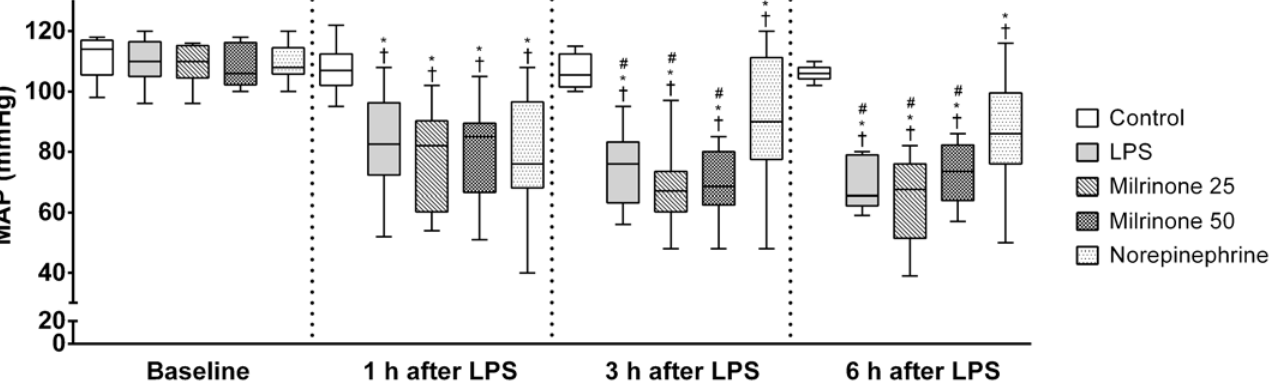
Fig 2. Evolution of mean arterial pressure during the experimental period. Sequential measurements were performed after one, three, and six hours of LPS injection. Control, non-endotoxemic animals (n = 10); LPS, endotoxemic animals (n = 10); Milrinone 25, endotoxemic and milrinone 0.25 μ g.kg -1 .min -1 treated animals (n = 10); Milrinone 50, endotoxemic and milrinone 0.50 μ g.kg -1 .min -1 treated animals (n = 10); Norepinephrine, endotoxemic and norepinephrine treated animals (n = 10). † p < 0.05 vs . group baseline; * p < 0.05 vs . Control group at the same time point; # p < 0.05 vs . Norepinephrine group at the same time